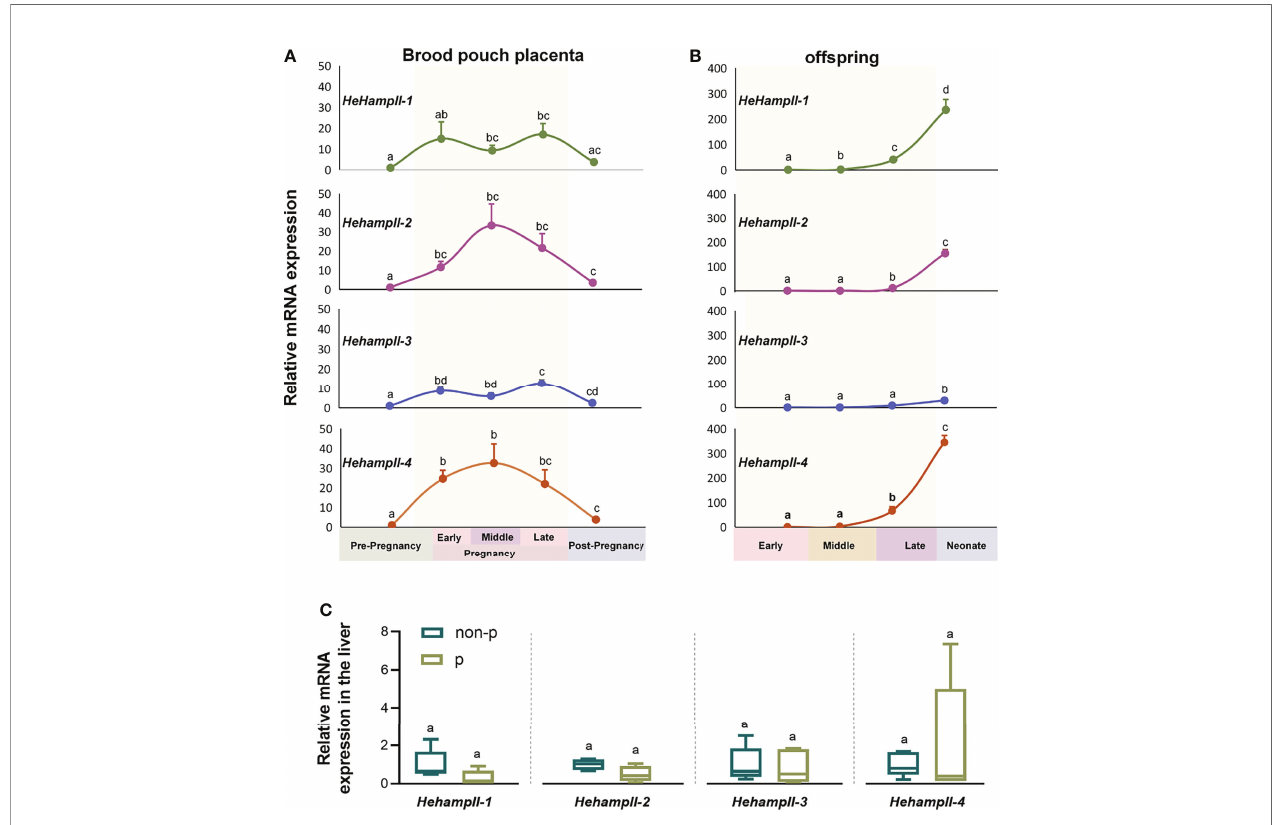
FIGURE 2 | The expression of HehampII genes in the brood pouch placenta (A) of lined seahorse ( Hippocampus erectus ) was higher during pregnancy, whereas the highest expression in the offspring (B) was observed at the post pregnancy period when the new-borns were just released from the closed brood pouch to the water environment (n ≥ 5, mean ± SEM). (C) No signi fi cant differences were detected in the expression of any seahorse HehampIIs in the liver between pregnant (p) and non-pregnant seahorses (non-p). Different lowercase letters indicate signi fi cant differences between them ( p <